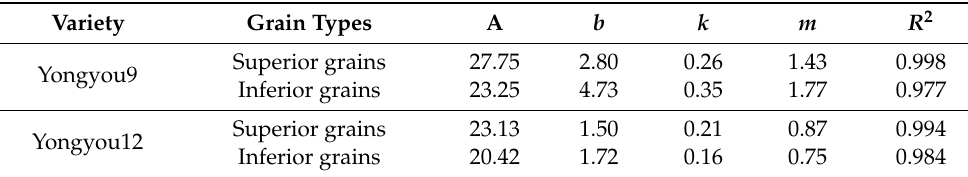
Table 1. Parameters of grain filling fitted by Richards’ equation.